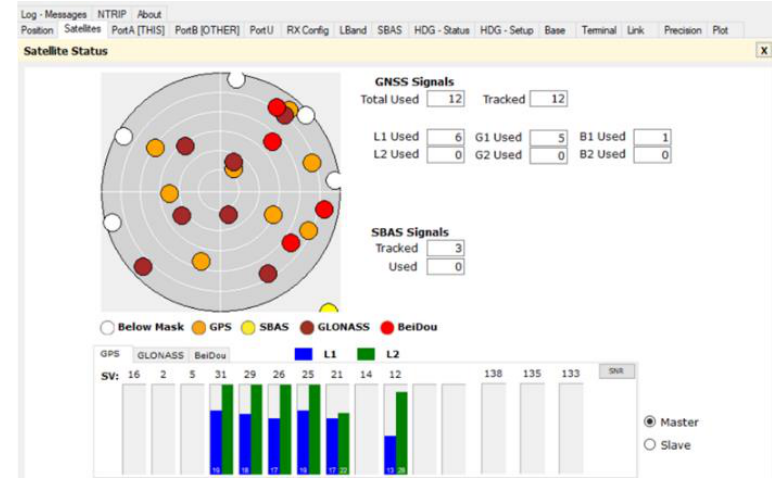
Figure 8. The system calibration in PocketMax3 software.